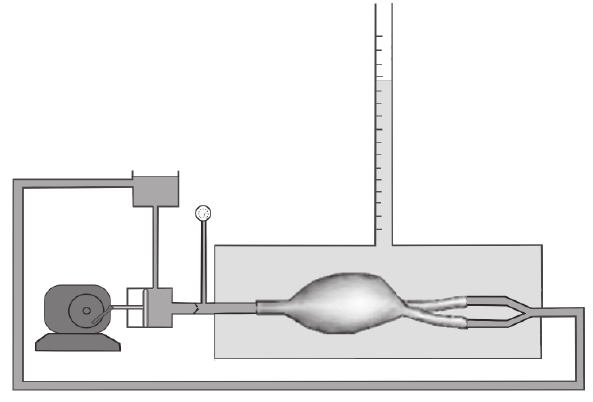
Figure 1 - Schematic representation of the perfusion system.